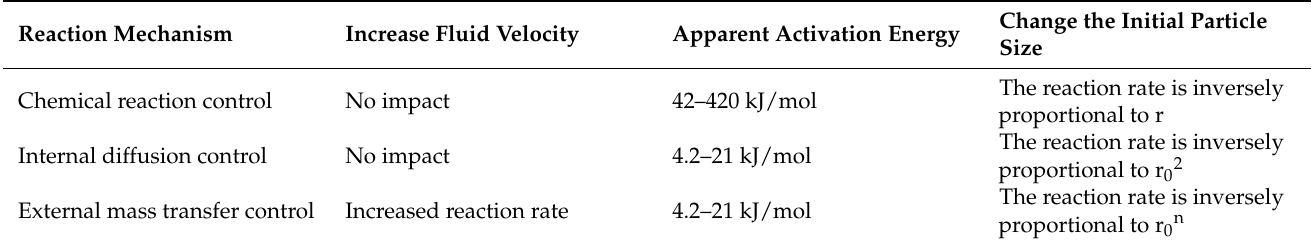
Table 2. Identification of reaction mechanism in different limiting